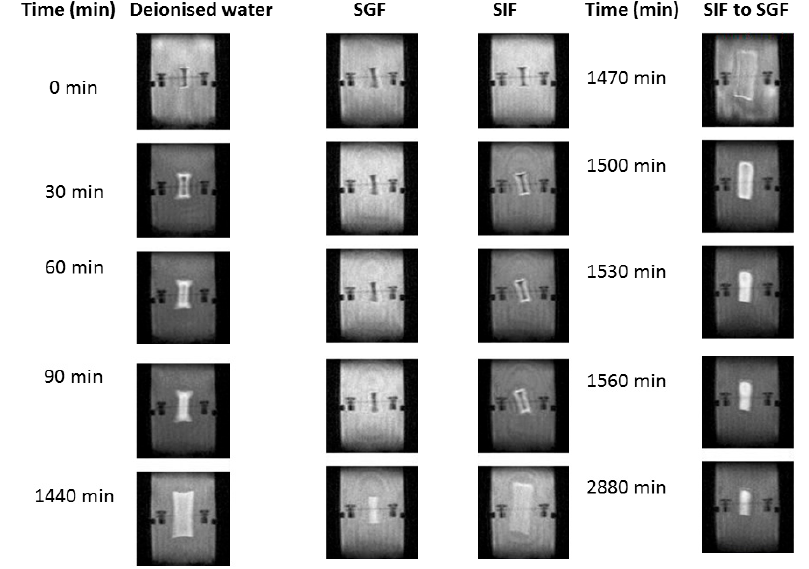
Figure 8. pH-responsive evaluation of the hydrogel mechanism was evaluated using MRI within deionized water, simulated gastric fluid (SGF) (pH 1.2) and simulated intestinal fluid (SIF) (pH 6.8). After 1440 min of evaluation of the sample in SIF, the same sample was introduced to SGF with images obtained up to 2880 min.